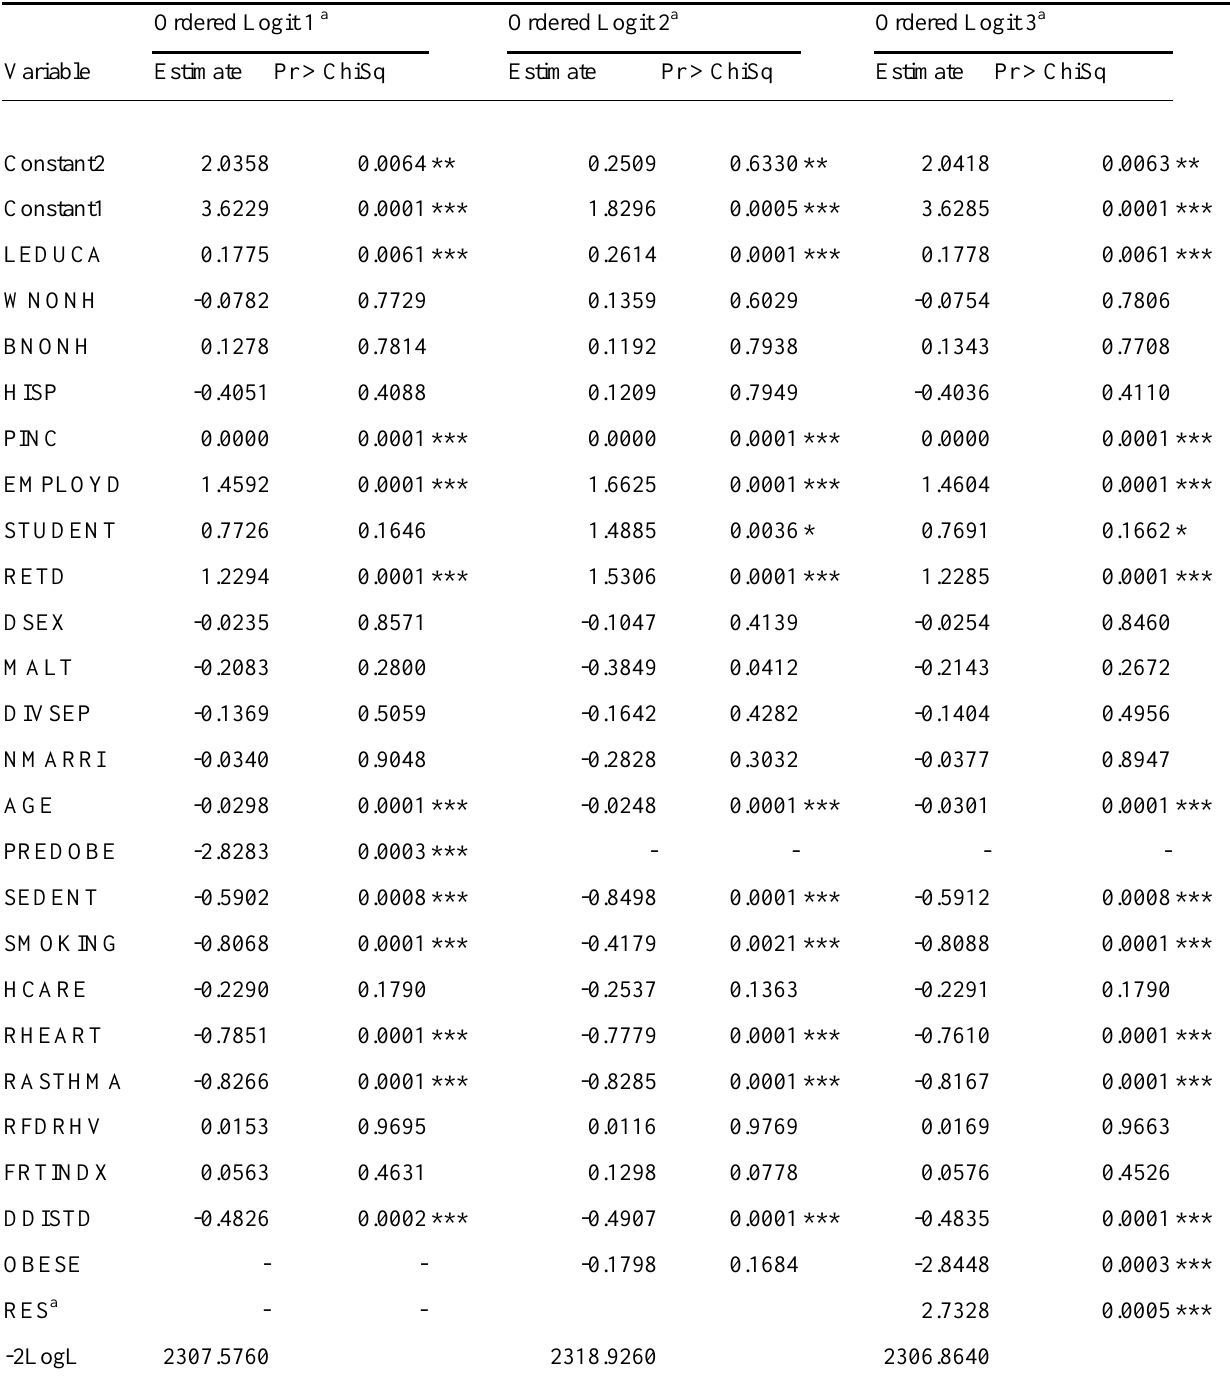
Table 4. Ordered logit estimates of self-assessed